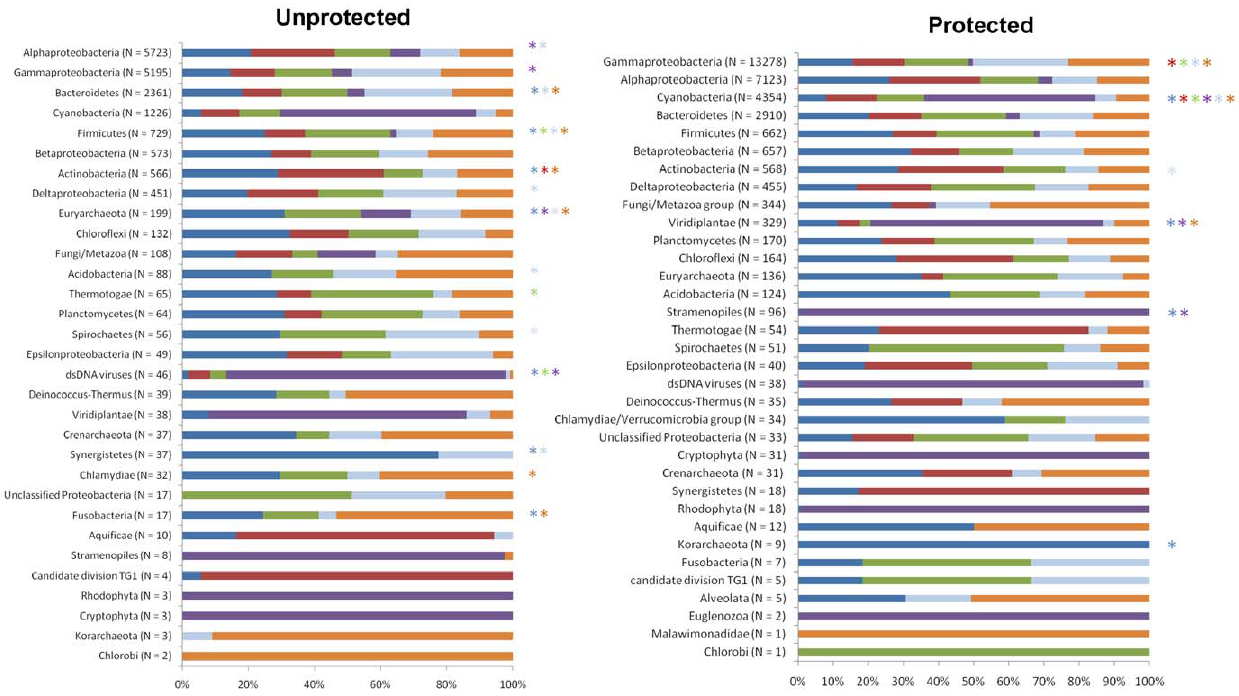
Figure 6. Contribution of different taxa to the six relevant subsystems (carbohydrate, phosphorous, nitrogen, virulence, stress response and photosynthesis) using MG-RAST (average 2009–2010). The colored stars represent a higher abundance (p , 0.5; CI 95%) of taxa for the respective subsystems in the unprotected or protected areas. N represents the number of sequences.